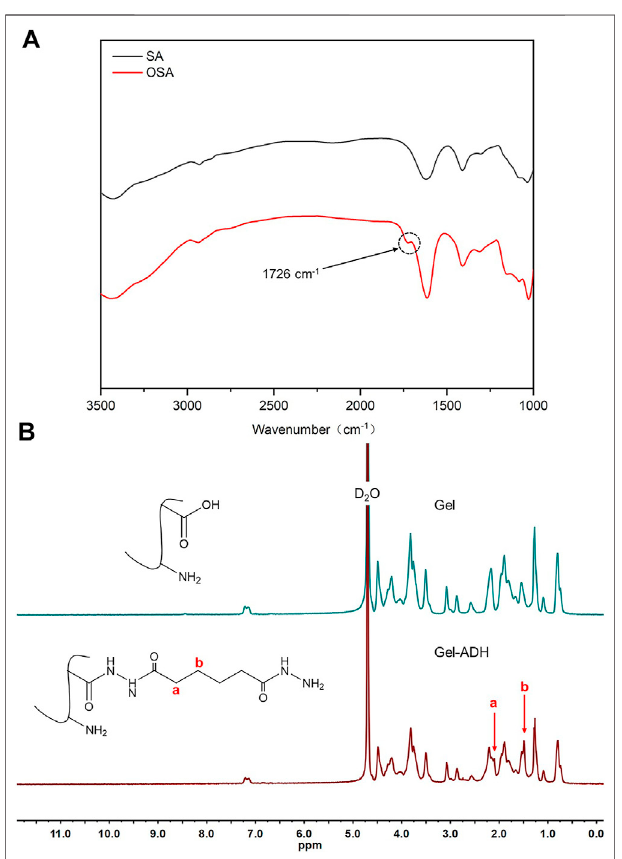
Frontiers in Chemistry |